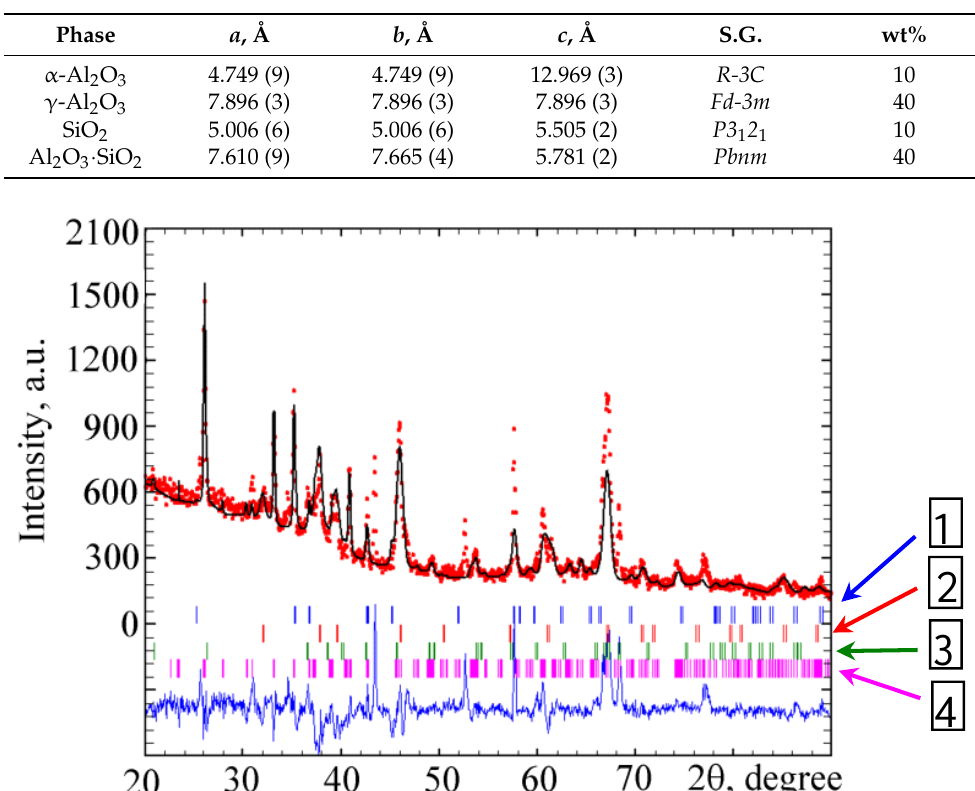
Table 2. Crystallographic parameters and quantitative content of phases in the PEO layer synthesized on the AK9 alloy in a weakly alkaline electrolyte of 3 g/L KOH + 2 g/L Na 2 SiO 3 + 3 g/L H 2 O 2 composition.